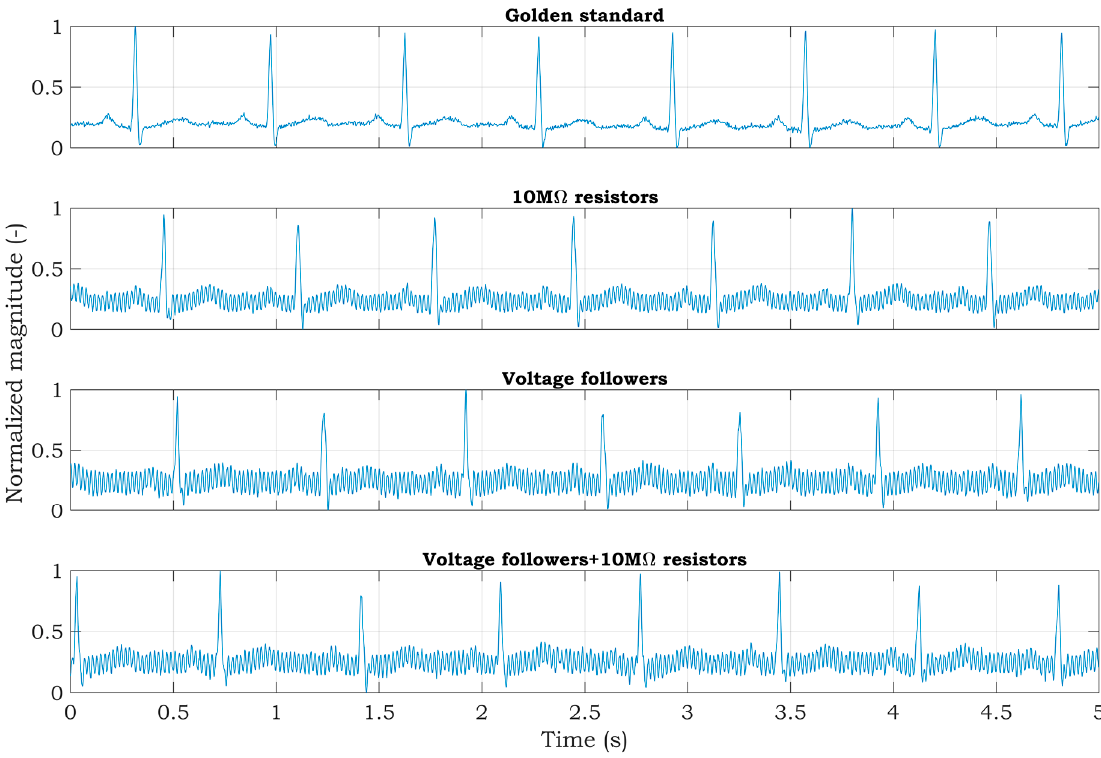
Figure 10. Raw ECG signals measured from a living subject.